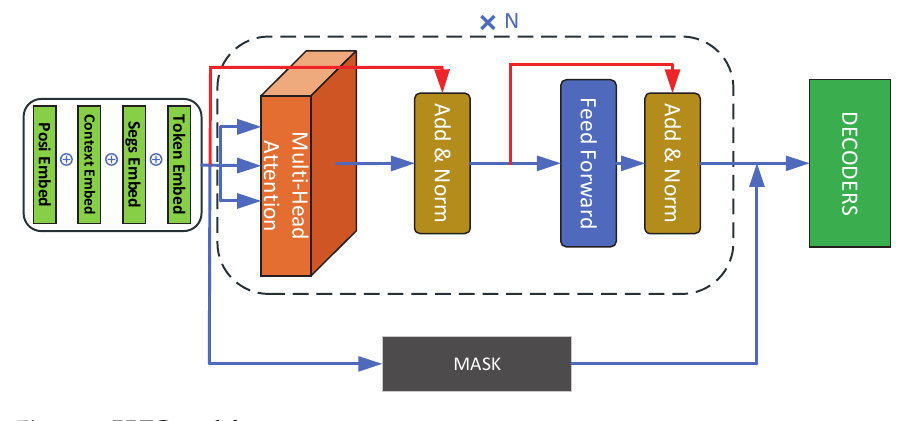
Figure 3. PBTG model structure.